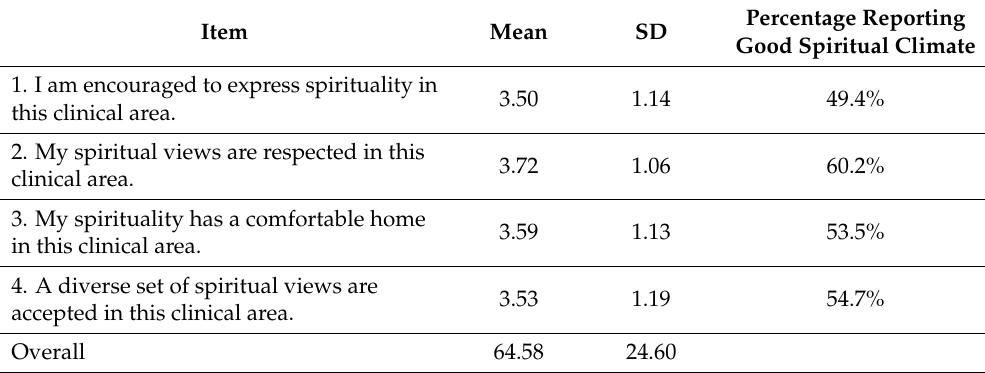
Table 2. The spiritual climate of hospitals in Saudi Arabia as perceived by nurses (n = 918).